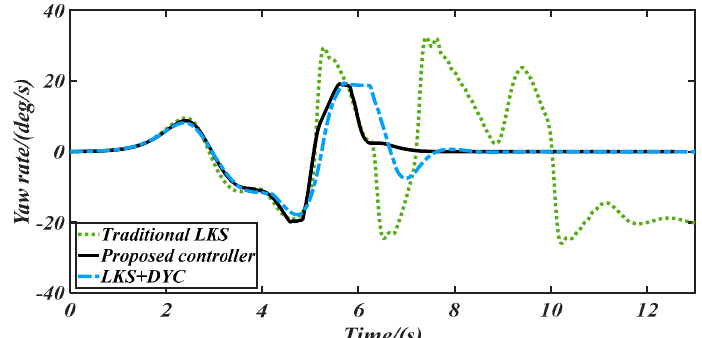
Figure 13. Vehicle yaw rate controlled by different controllers.